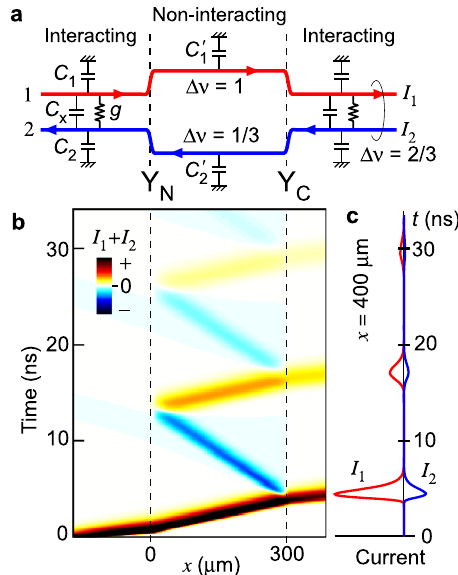
Fig. 5 Charge fractionalization calculated using a plasmon model. a Non- interacting edge channels Δ ν = 1 and Δ ν = 1/3 in the central region and composite Δ ν = 2/3 channels in the interaction regions on both sides, forming junctions Y N and Y C . b Time evolution of a charge wave packet initially prepared in the left interacting region at x = − 200 μ m, showing full transmission and full re fl ection at Y N ( x = 0) and charge fractionalization at Y C ( x = 300 μ m). The sum of the currents I 1 and I 2 in the original Δ ν = 1 and 1/3 channels, respectively, is plotted in a color scale (red for positive and blue for negative in an arbitrary unit). The numerical simulation was performed using realistic parameters: capacitances C 1 = C 2 = C x = 0.07 nF/m; scattering conductance g inducing l eq = 10 μ m in the interacting regions; C 1 ’ = C 2 ’ = 0.4 nF/m in the non-interaction region. c Time-dependent I 1 and I 2 at x = 400 μ m in right interaction region. Each packet shows I 2 = − I 1 /3 of the charge